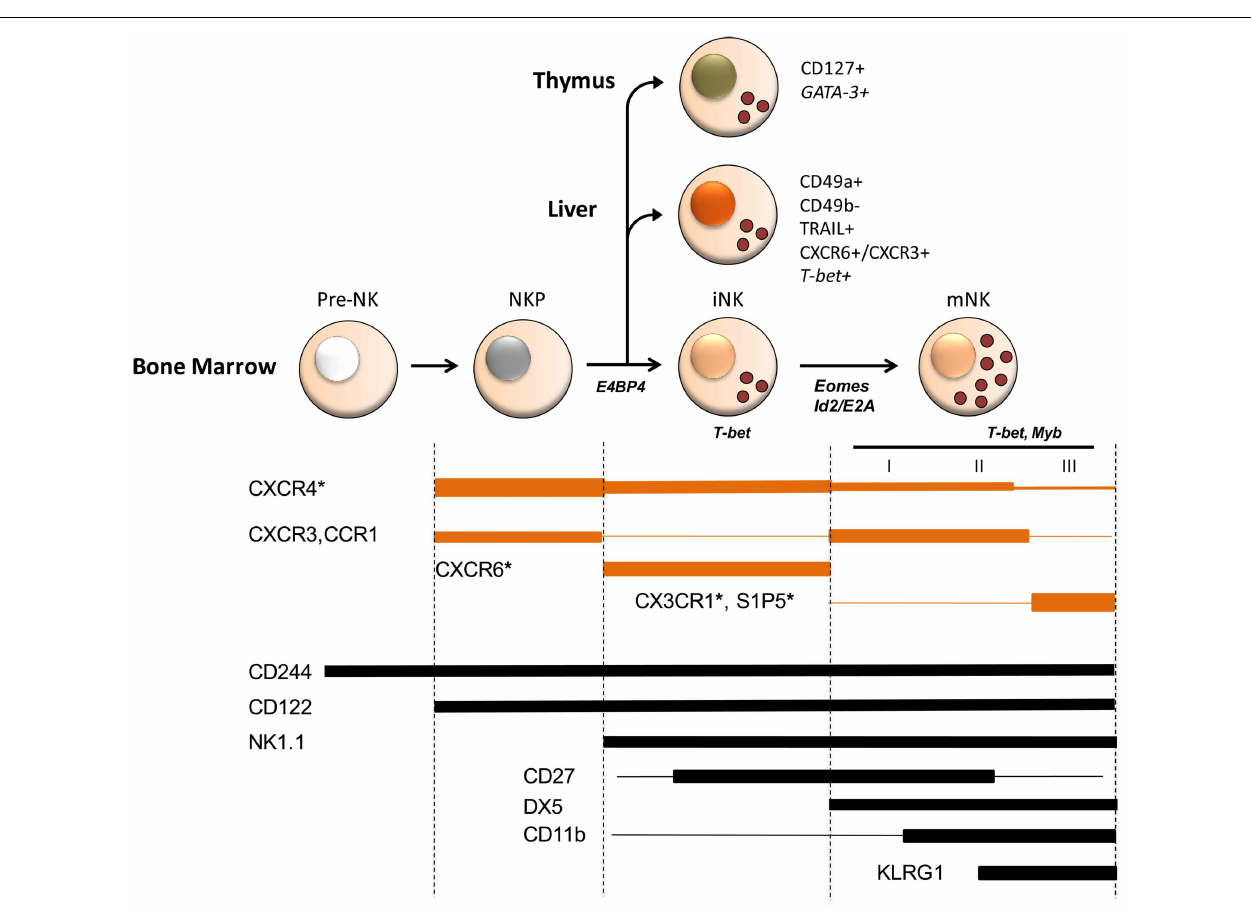
associated to selective functions in NK cell localization and maturation in BM. For example, CX3CR1 and S1P 5 play an important and non-redundant role in mature NK cell egress from BM. Although, it is not known whether these two receptors are co-expressed by the same cell or expressed by different cell populations, prompting an investigation on how they co-operate to allow the efficient export of NK cells into circulation. Chemokine receptor expression overlaps that of several transcription factors active during NK cell development. Indeed some of these transcription factors, includingT-bet and Myb were shown to directly affect chemokine and S1P receptor expression. Shown are transcription factors at the stage where they play a role